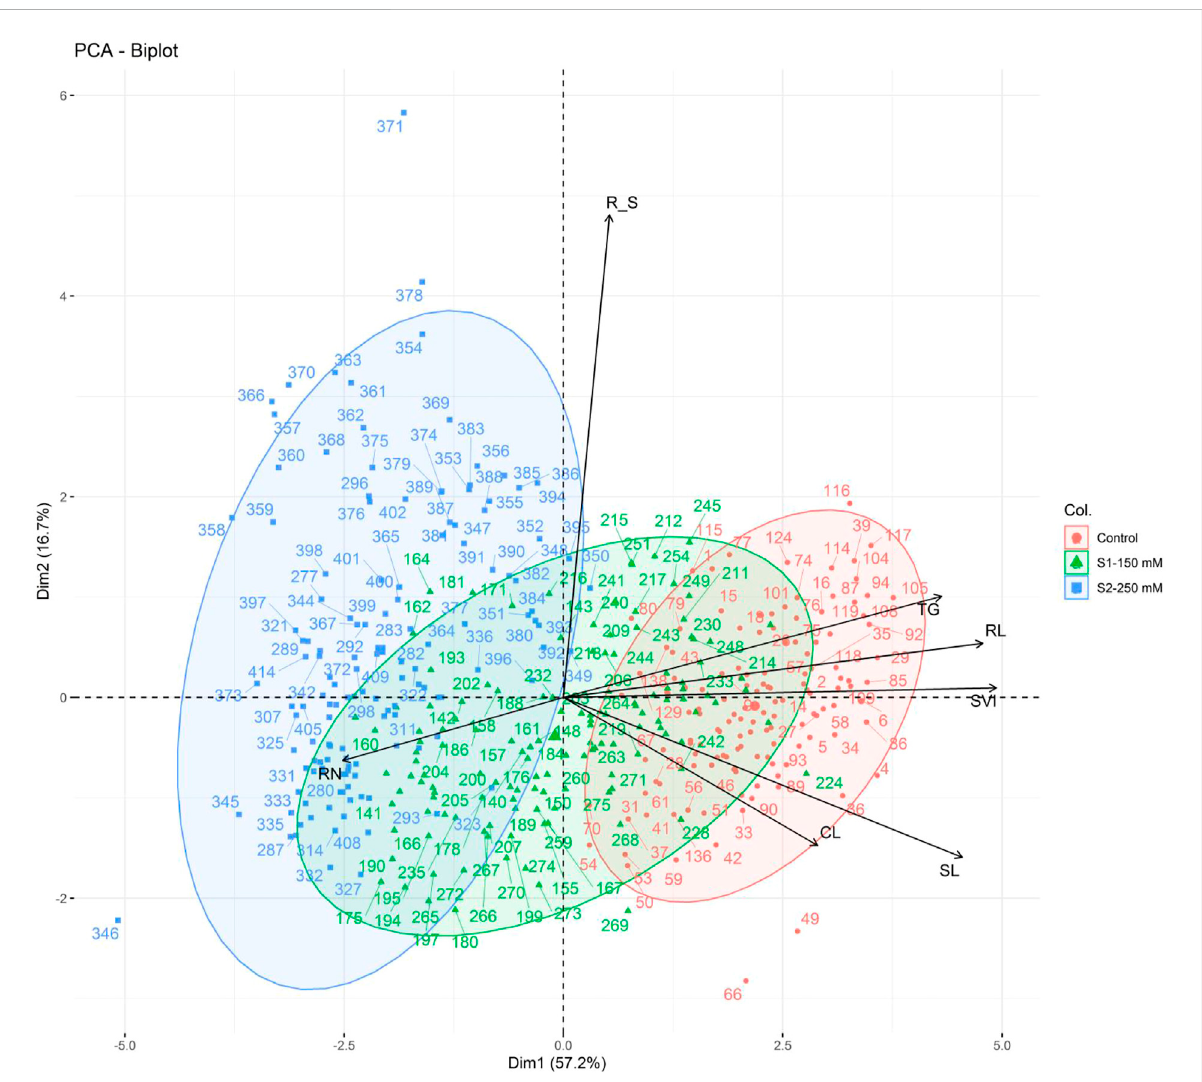
FIGURE 6 PCAofthemorphologicaltraitsmeasuredin138wheatgenotypesincontrol(red)andsaltstress[S1-150 MmNaCl(blue)andS2-250 MmNaCl)] conditions based on the fi rst two components. TG, total germination percentage; RN, numbers of roots; CL, coleoptile length; SL, shoot length; RL, root length; R_S, root to shoot length ratio; SVI, seedling vigor